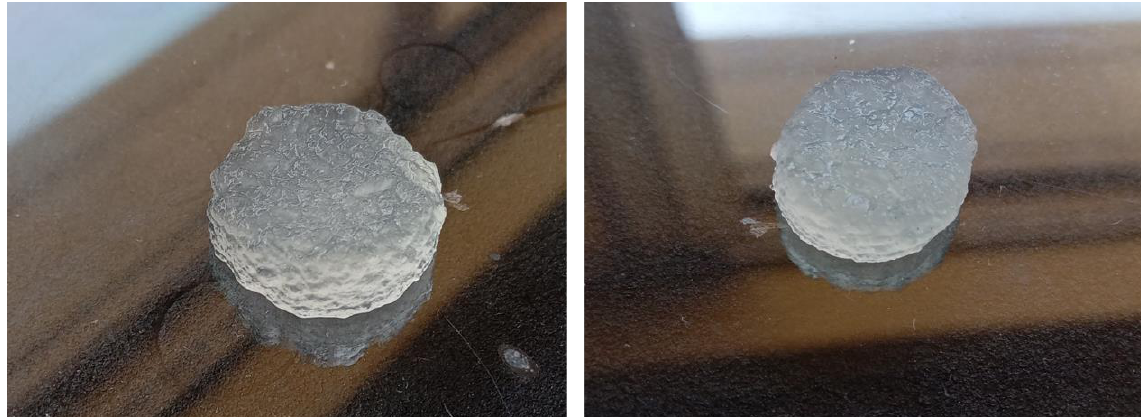
Figure 9. Three-dimensional printing process of the sodium alginate gel cylinders.